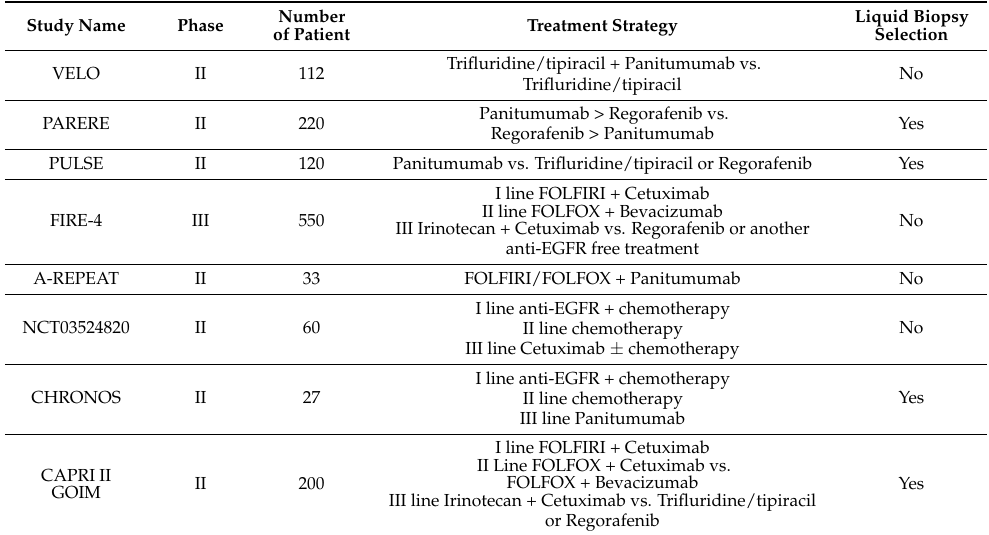
Table 2. Rechallenge with anti-epidermal growth factor ongoing